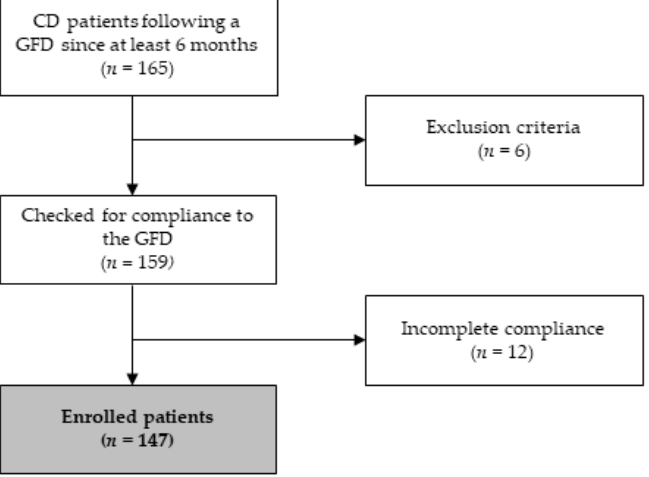
Figure 1. Patient flow chart. CD: celiac disease; GFD: gluten-free diet. Female gender was predominant, and the median age at enrolment was 42 years (interquartile range 28–56; Table 1). The majority of patients had been on a GFD for more than 5 years (113 cases, 76.9%), 22 (15.0%) for between 2–5 years, and 12 (8.2%) for less than 2 years. Forty cases (27.2%) had been diagnosed in childhood (<15 years). Only 9 (6.1%) patients were overweight or obese at diagnosis. Table 1. Characteristics of the study population. Continuous variables are expressed as median (interquartile range), categorical variables as frequencies